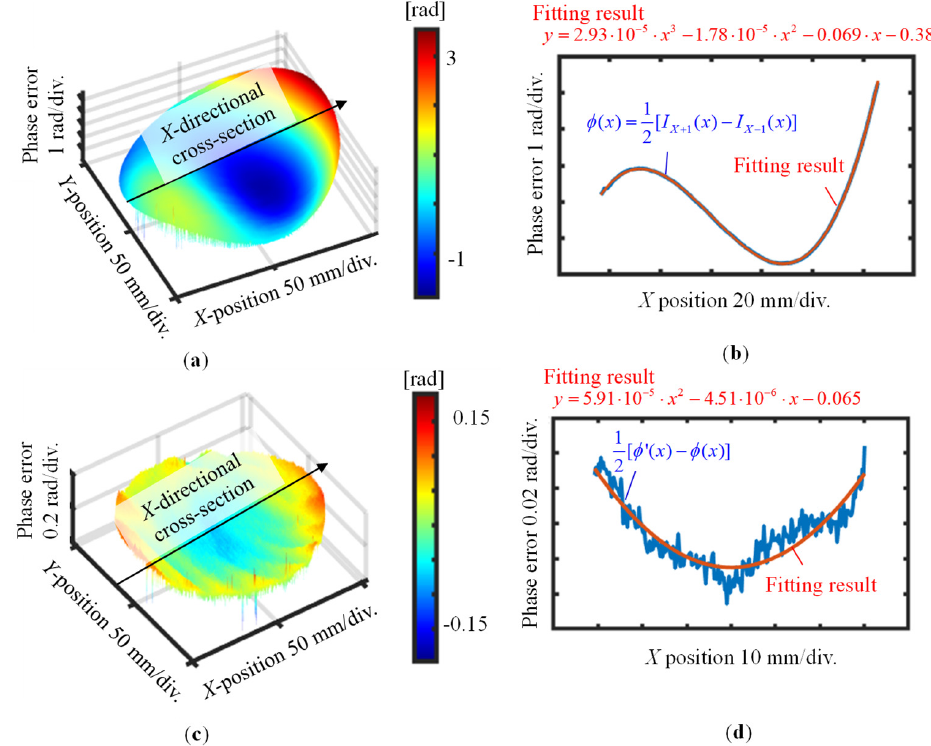
Figure 13. Measured first-order differential diffracted wavefronts before and after shift ( X -direction): ( a ) Measured first-order differential diffracted wavefront before the shift; ( b ) X -directional cross-sectional profile of the differential wavefront in ( a ); ( c ) Difference of the first-order differential diffracted wavefront before and after the shift; ( d ) X -directional cross-sectional profile of the differential wavefront in ( c ).